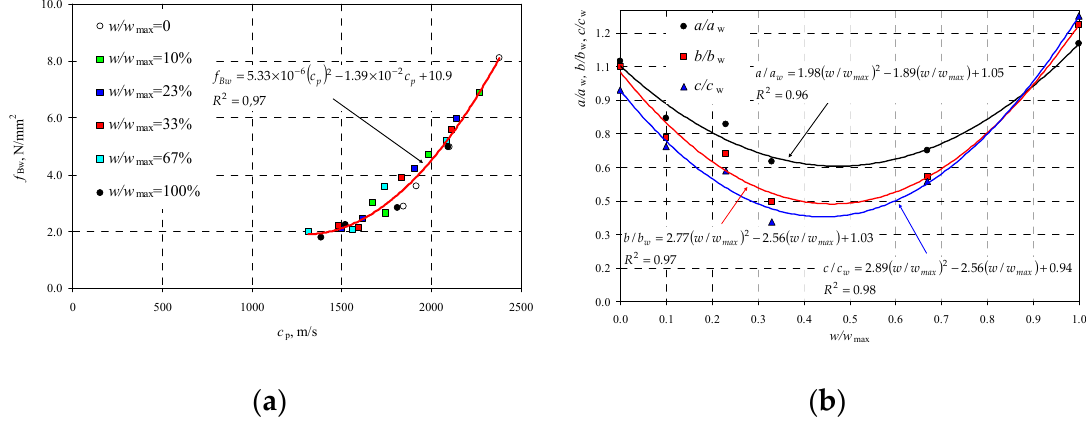
Figure 9. Results from ultrasound velocity testing: ( a ) common curve f Bw – c p for all AAC densities and moisture levels, and ( b ) equations for curve coefficients at varying moisture content in AAC f Bw